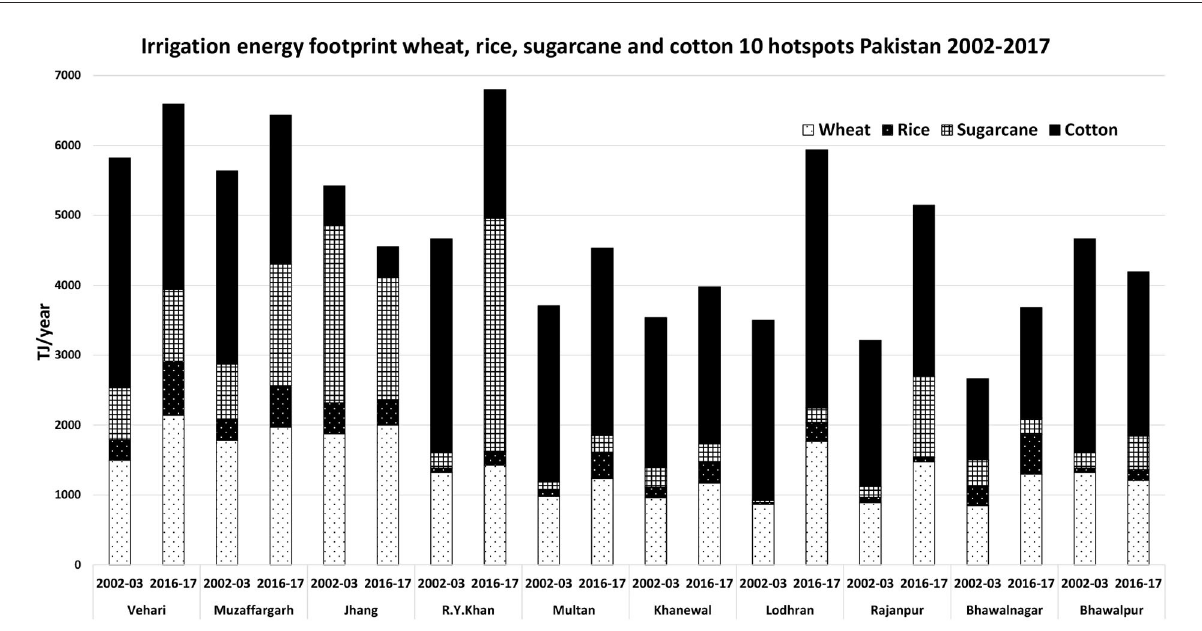
FIGURE7 Ten hotspot districts with high total irrigation energy footprints for wheat, rice, sugarcane, and cotton and the development of irrigation energy footprints between 2002–03 and